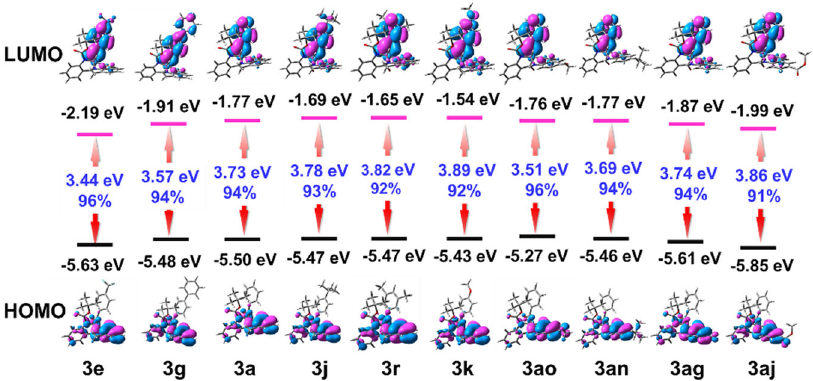
Fig. 10 Density functional theory calculations. Molecular orbital and energy levels of benzo [6,7]azepino[2,3- b ]quinolines, calculated at the B3LYP/6- 2122558 ( 8 , Supplementary Data 7), respectively. These data can be obtained free of charge from The Cambridge Crystallographic Data Centre via http://www.ccdc.cam.ac. uk/data_request/cif.